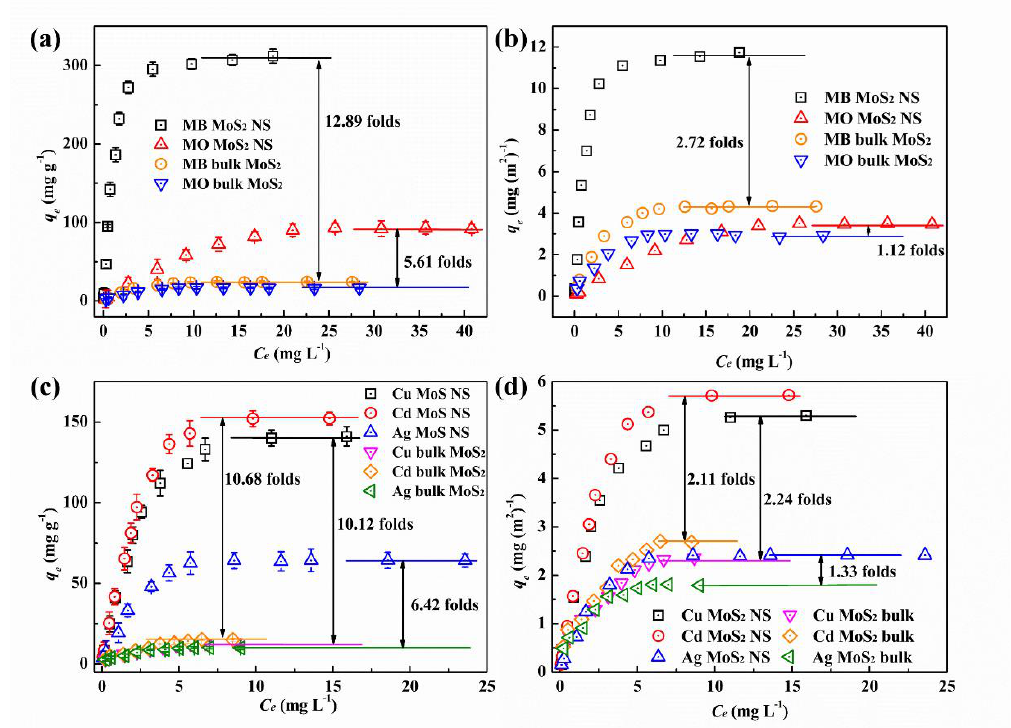
Figure 7. Equilibrium adsorption capacity ( a , c ) and standardized equilibrium adsorption capacity ( b , d ) of dyes (MO and MB) and heavy metals (Cu 2 + , Cd 2 + , and Ag + ) for bulk MoS 2 and MoS 2 NS.